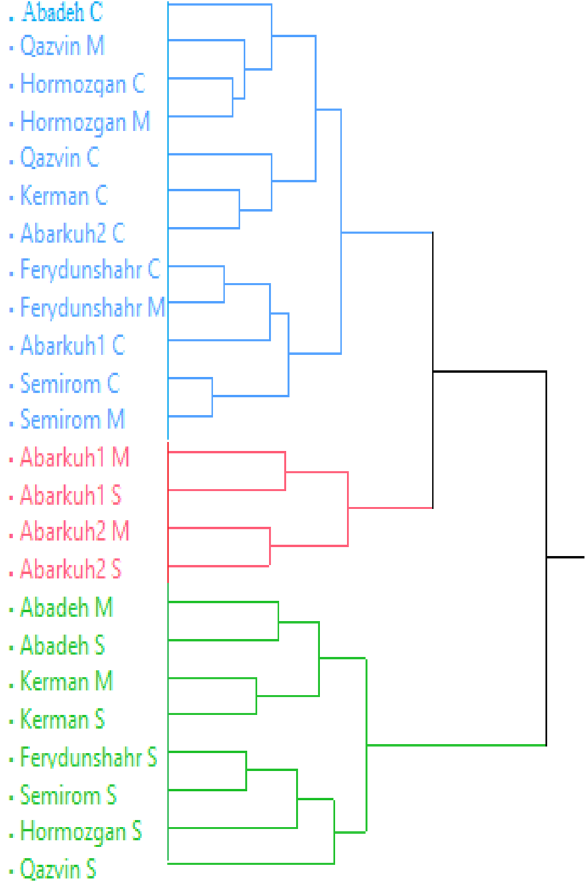
Figure 1. Dendrogram generated from cluster analysis of 8 Moshgak populations in three irrigation regimes based on phytochemical characters using WARD based on the Squared Euclidean dissimilarity